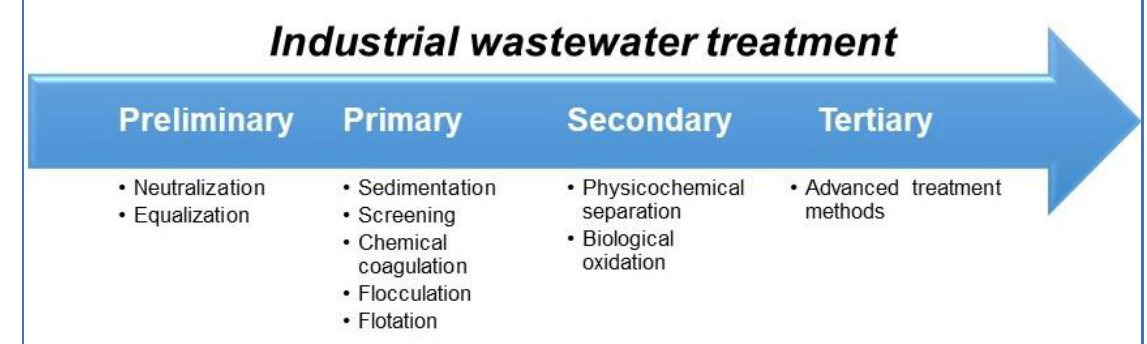
Figure 3. Distribution of industrial wastewater treatment methods according to treatment mechanism.